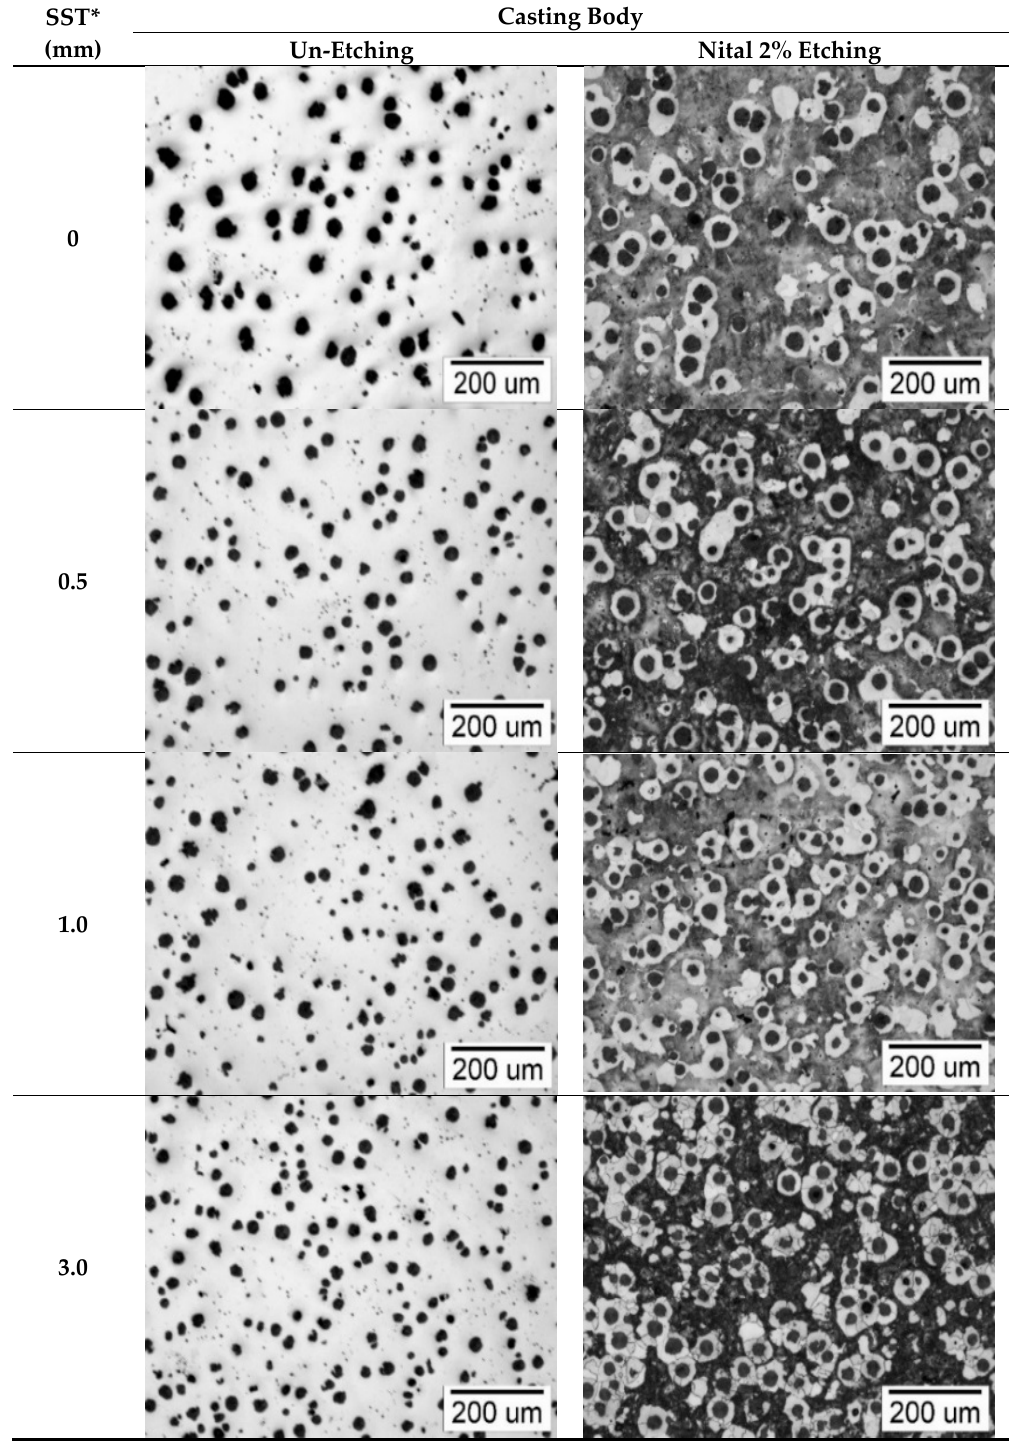
Figure 5. Structure in the ductile iron casting body (un-etching and Nital 2% etching) at different thicknesses of the steel sheet (SST) applied on the inner mould surface, before pouring.